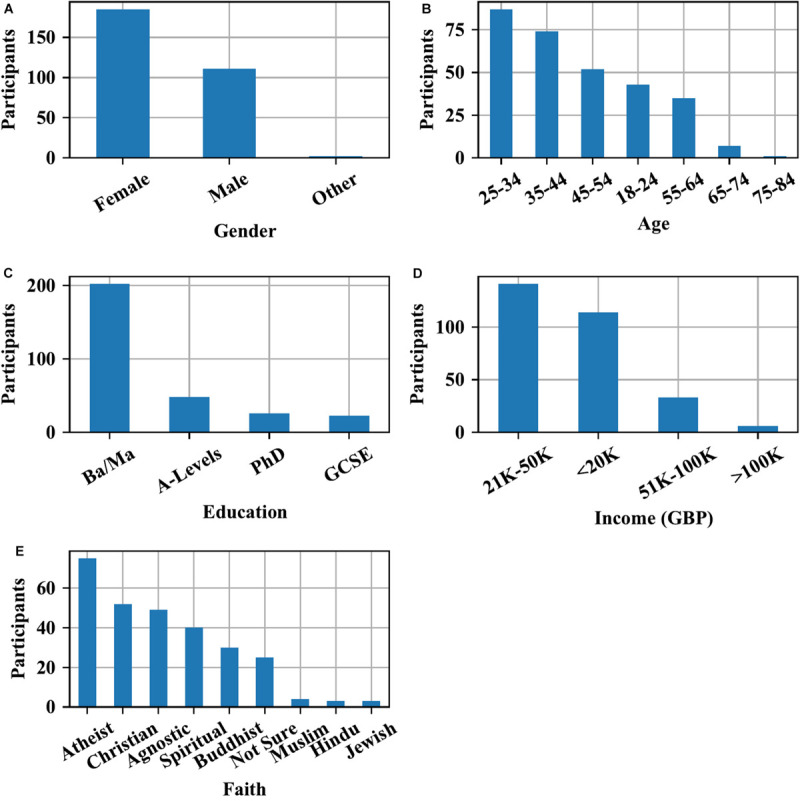
Distribution of sample characteristics in the sample of 300 respondents. (A) shows self-identified gender, (B) shows age at time of responding, (C) shows highest degree attained, (D) shows average income per year, (E) shows religious affiliation.